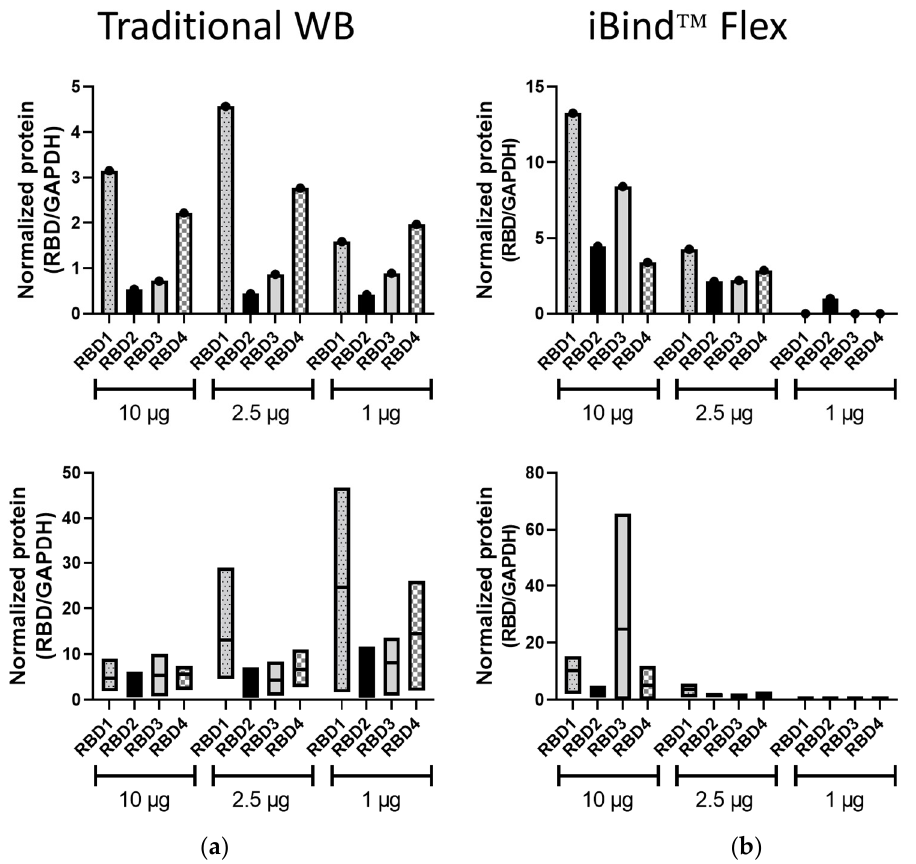
Figure 3. Normalized RBD expression in traditional and iBind™ Flex membranes. RBD (1–4) expression in both traditional WB ( a ) and iBind™ Flex membranes ( b ) was normalized to GAPDH expression using band volume obtained from Image Lab analysis. Top bar diagrams represent quantitation from the representative WBs in Figures 1 and 2. Bottom graphs are floating bar representations (minimum, maximum, and mean) of band volume quantitation from three independent experiments.